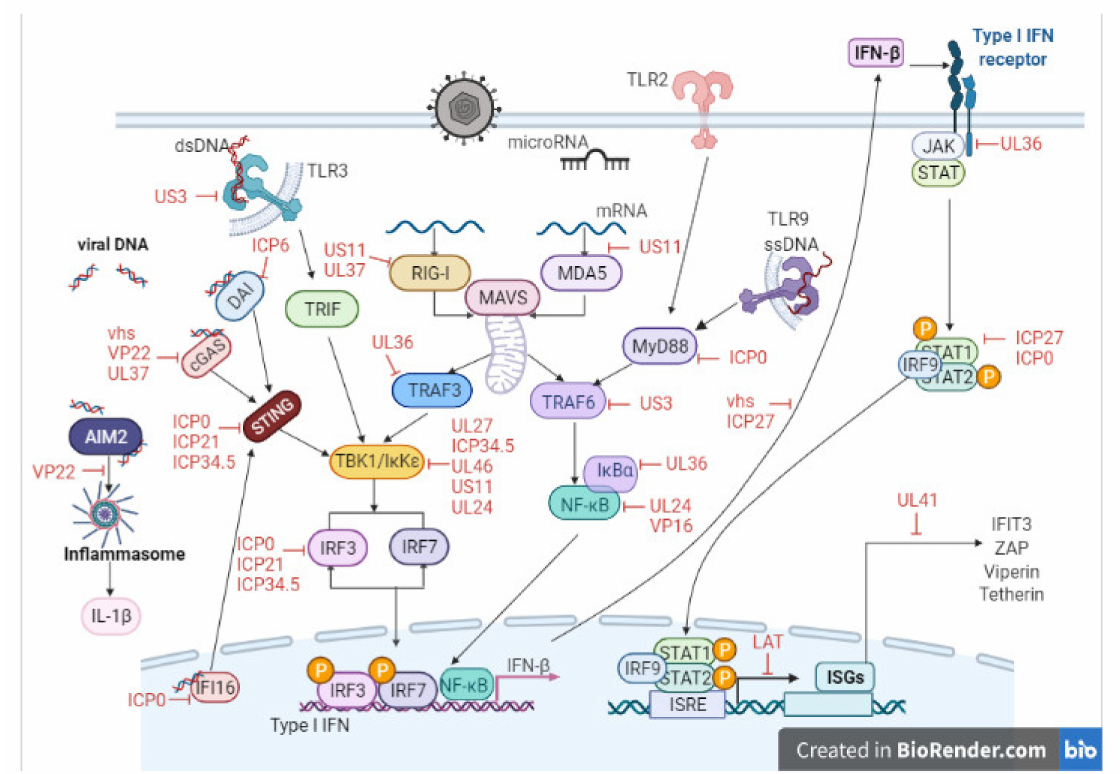
Figure 4. Schematic showing host cell–virus interactions leading to the initiation of an antiviral immune response. Red text indicate points on these pathways targeted by HSV-1 as part of its viral immune evasion strategy. Created with BioRender.com (https://biorender.com/, accessed on 1 July